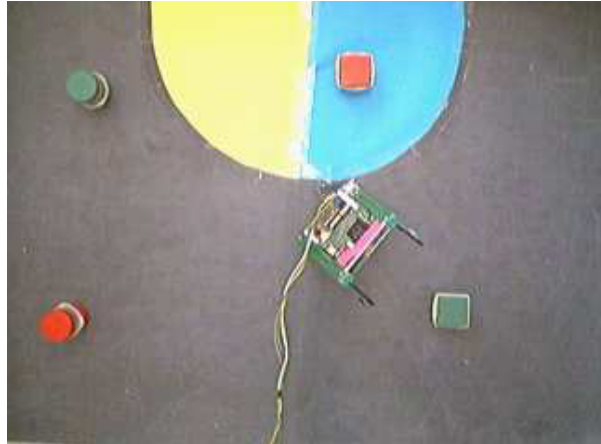
Figure 6. Example image from top mounted camera. A pink tape has been placed on the Khepera gripper to facilitate recognition of the robot’s position and